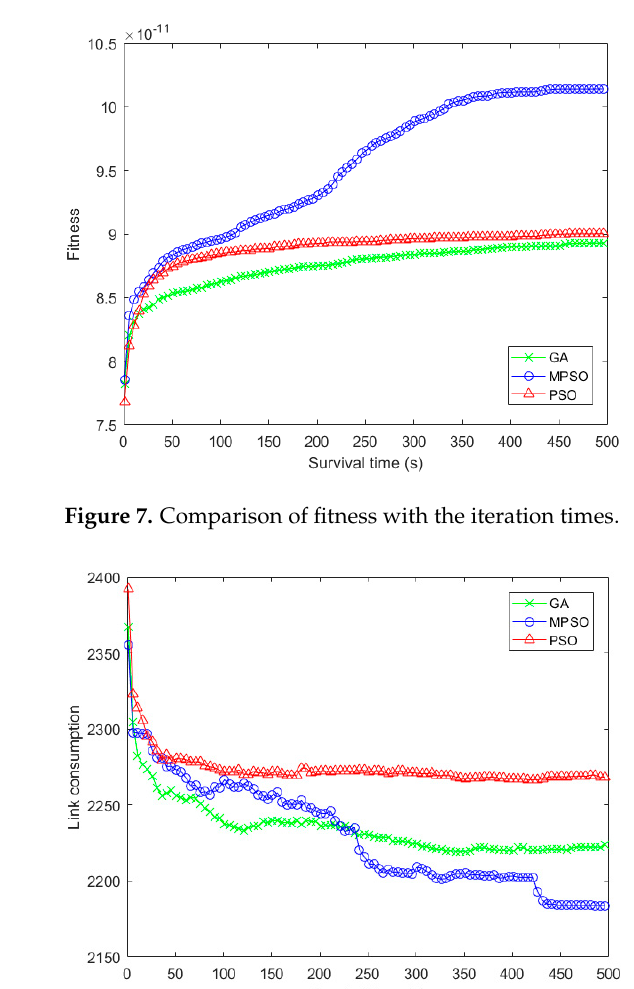
Figure 8. Comparison of link consumption with the iteration times.